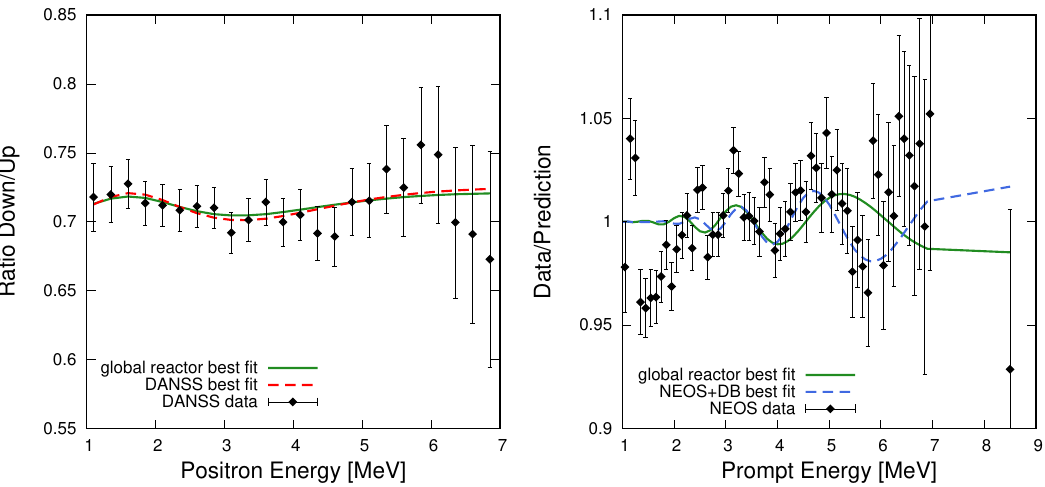
Figure 1 . Observed spectra for the DANSS (left) and NEOS (right) experiments compared to the predicted spectra at the individual best (cid:12)t points (dashed) and the best (cid:12)t point from a global analysis of all reactor data (solid). The left panel shows the ratio of the observed event rates at the two detector locations in DANSS (24 bins). The right panel shows the NEOS spectral data relative to the prediction extrapolated from the measured Day Bay spectrum (60 bins). The best (cid:12)t points are (cid:1) m 2 = 1 : 32 eV 2 , sin 2 (cid:18) 14 = 0 : 012 for DANSS, (cid:1) m 2 = 1 : 78 eV 2 , sin 2 (cid:18) 14 = 0 : 013 for NEOS + 41 41 Daya Bay, and (cid:1) m 2 = 1 : 29 eV 2 , sin 2 (cid:18) 14 = 0 : 0089 for the (cid:12)t to all reactor data, assuming a free 41 normalization for the neutrino (cid:13)uxes from the four main (cid:12)ssible